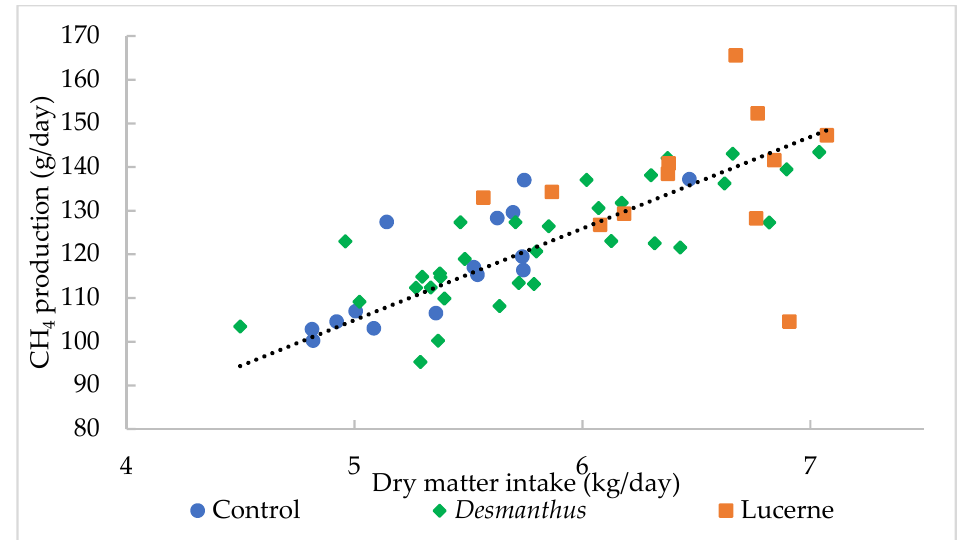
Figure 2. The relationship between dry matter intake (kg /day) and CH 4 production (g/day). The relationship can be described as CH 4 production (g/day) = 20.99X, where X = dry matter intake (kg/day) R 2 = 0.73, p < 0.001.